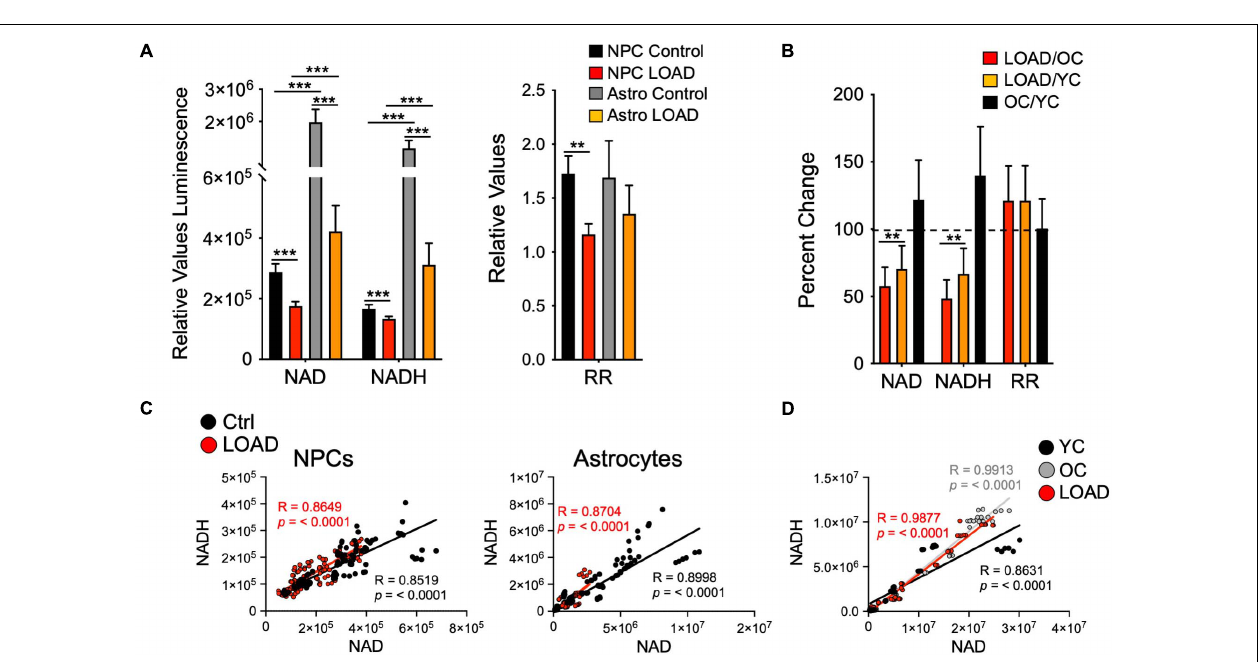
FIGURE 2 | Schematic representation of an in vitro cellular platform for studying LOAD. LOAD patients’- and control individuals’-derived fibroblasts or blood cells are used to generate induced neurons ( i -Neurons) or astrocytes ( i -Astrocytes), and iPSCs for the production of NPCs, neurons, and astrocytes to study LOAD in context of brain cell development, cell types, function, and age. The cell samples analyzed in our studies are summarized in Supplementary Table 1 .